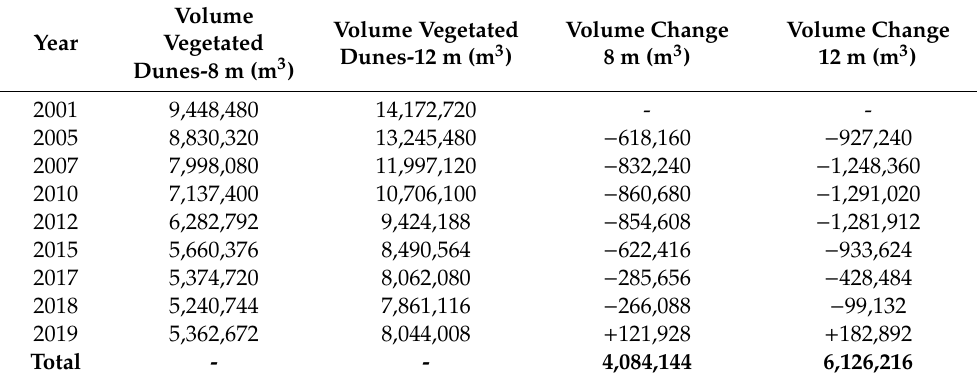
Table 4. Volumetric change